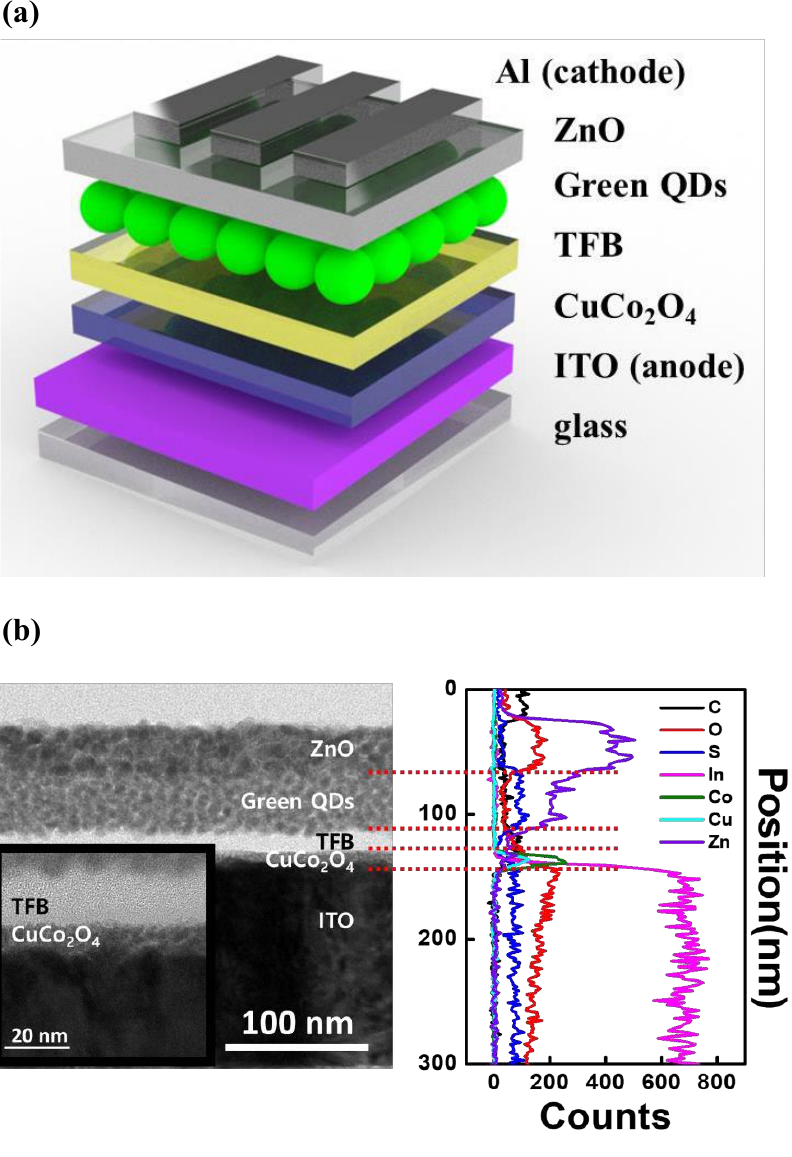
Figure 6. ( a ) Structure of QLEDs with CuCo 2 O 4 HIL. ( b ) Cross-sectional HR-TEM image of the QLED with CuCo 2 O 4 HIL and EDS line scan of the elemental distribution.